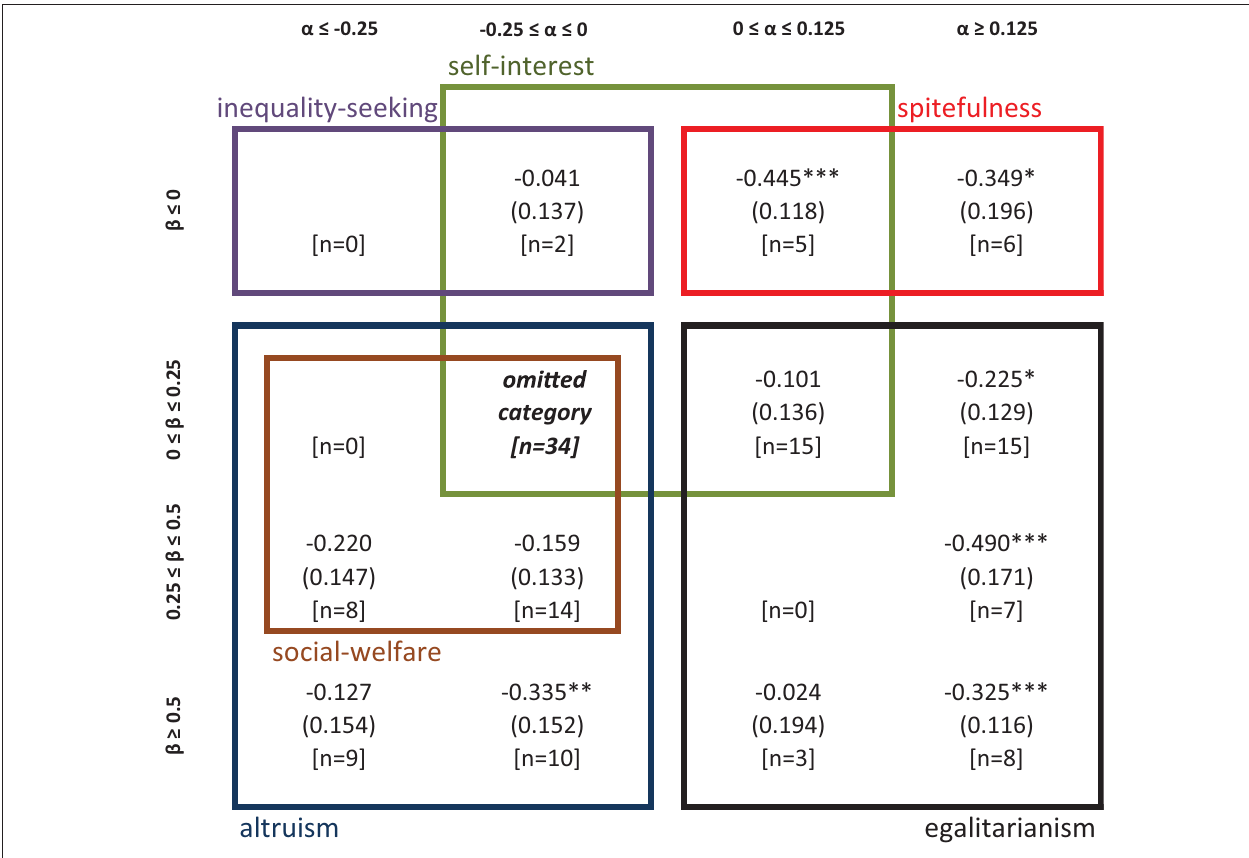
FIGURE 6 | Output of multinomial Probit regression (Study 2). In each cell, the figure shows the coefficient of CRT obtained by comparing that specific social preference category with “ α ǫ [ − 0.25 , 0] , β ǫ [0 , 0.25] ”. * , ** , *** p -values lower than 0.10, 0.05, and 0.01, respectively. Ll = − 300.325 , Wald χ 2 = 50.17 ( p < 0.01 ), N = 136 . Robust standard errors clustered on individuals are shown in parentheses, and the number of observations in square